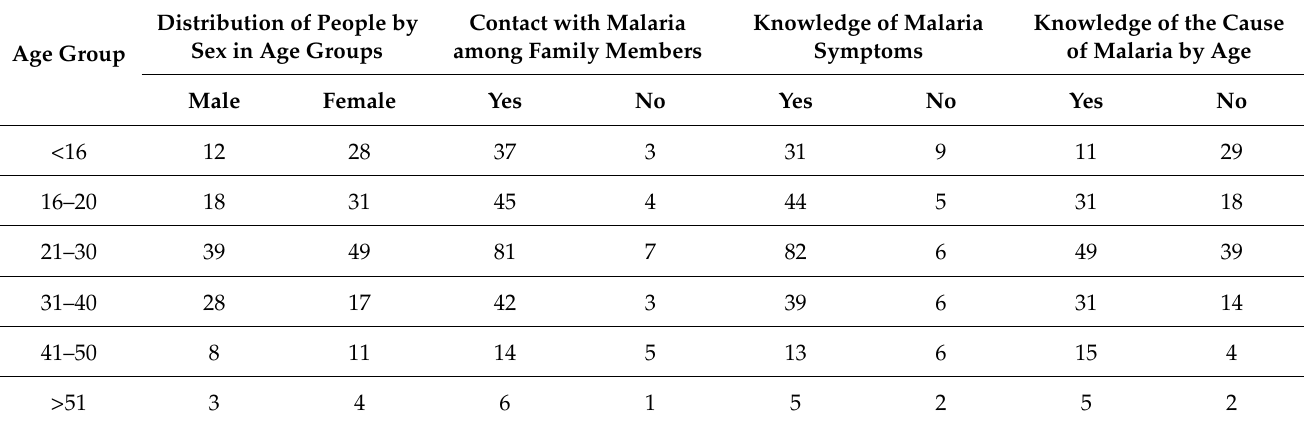
Table 1. Knowledge about malaria depending on the age of the